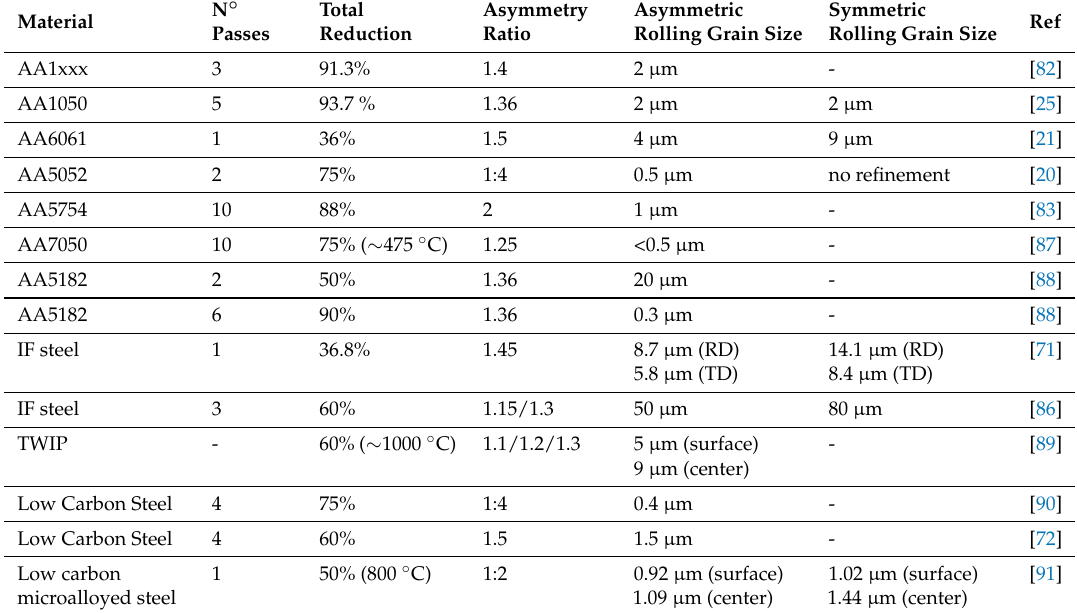
Table 2. Overview of grain refinement produced by the Asymmetric rolling (ASR) for aluminum alloys and